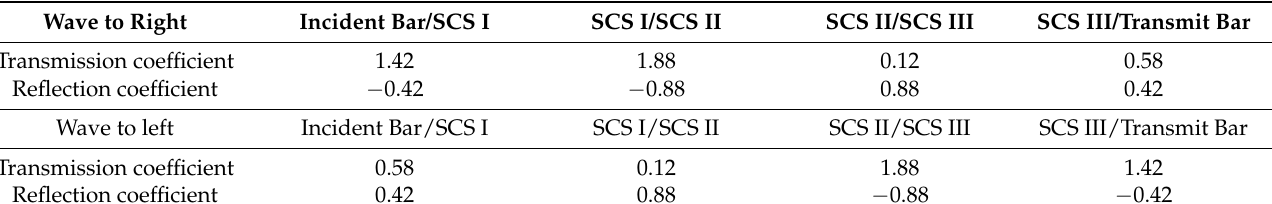
Table 5. Interface parameters of stress wave propagation analysis.